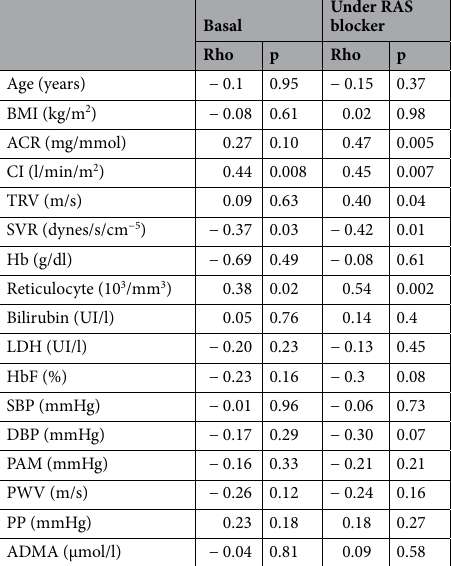
Table 3. mGFR correlates before and under RAS blockade. BMI: body mass index; ACS: acute chest syndrome; SBP: Systolic blood pressure; DBP: diastolic blood pressure; MAP: mean arterial pressure; HR: heart rate; PP: pulse pressure; PWV: pulse wave velocity; CI: cardiac index; LVMI: left ventricular mass index; TRV: tricuspid regurgitation velocity; SVR: systemic vascular resistance; ACR: albumin creatinine ratio; Hb: haemoglobin; LDH: lactic